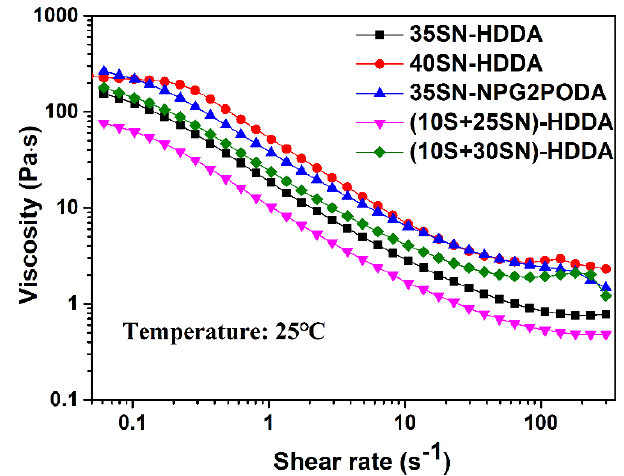
Figure 3. Rheological curves of slurries with different formulation.